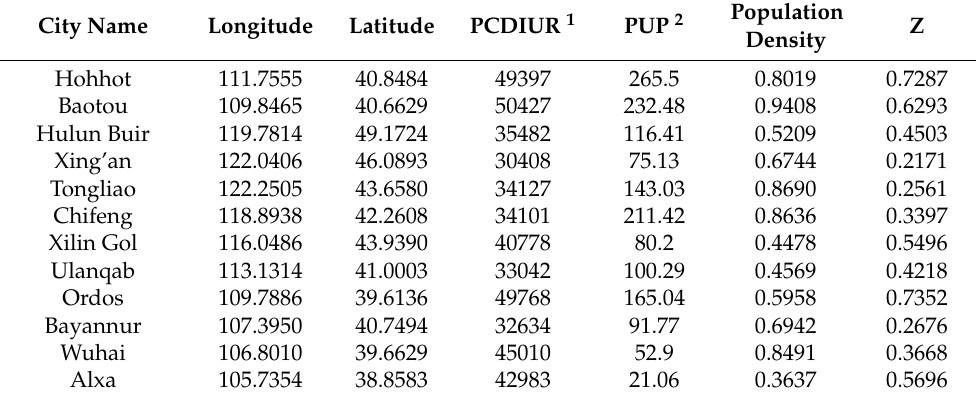
Table 2. The initial data.